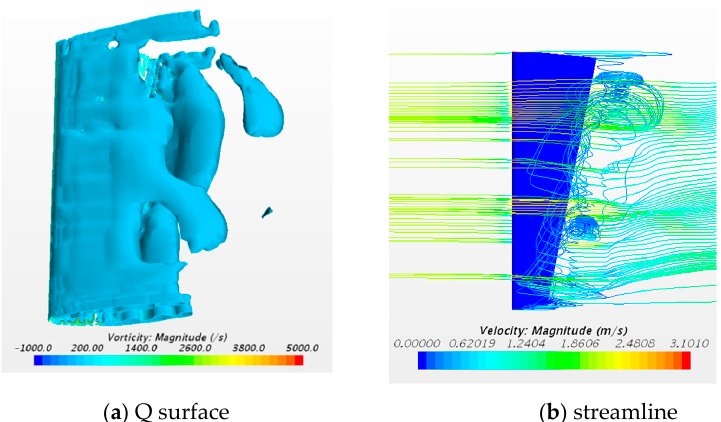
Figure 11. Vortex structures and streamlines near the surface of the base blade when attack angle is 24° (the iso-surfaces in ( a ) corresponds to Q = 150 and velocity magnitude contour of streamline in ( b )).